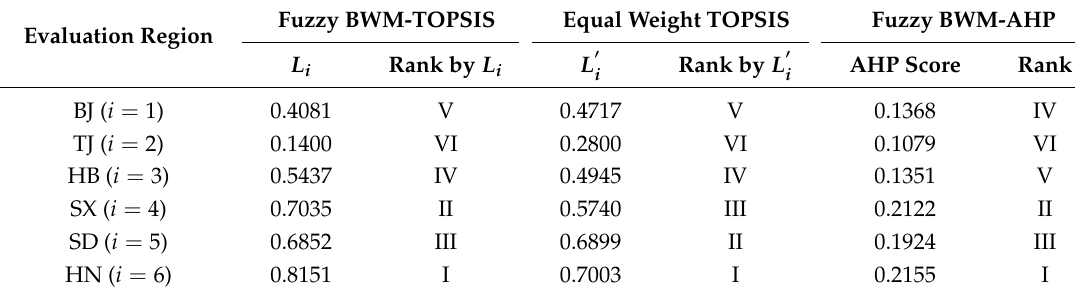
Table 7. Results and comparison